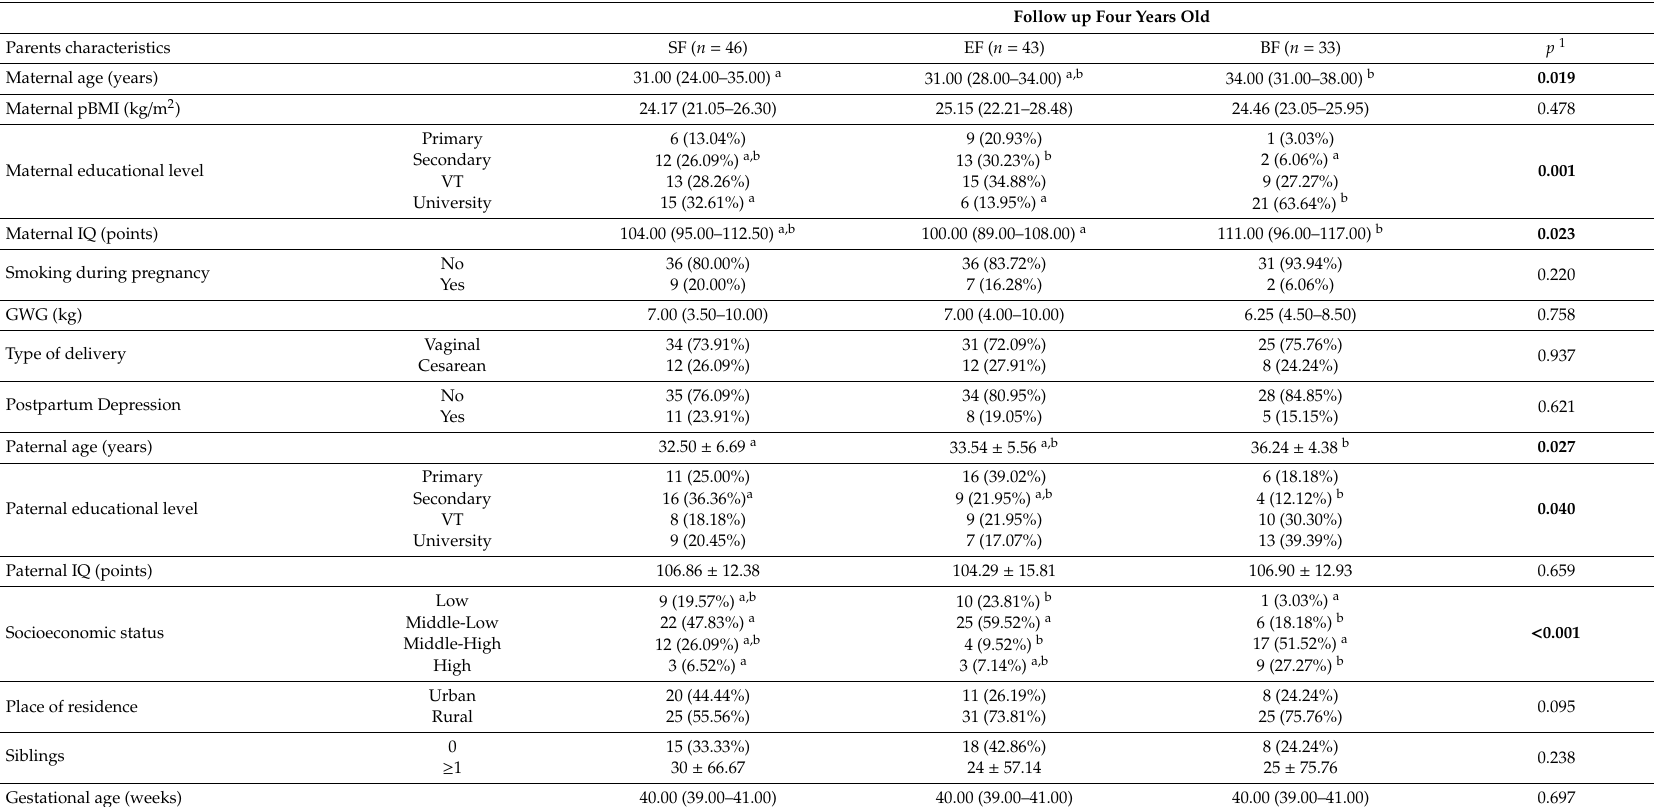
Table 1. Baseline characteristics of children and parents participating in the COGNIS